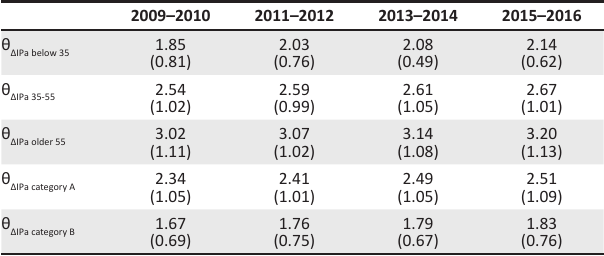
FIGURE 9: Summary of panel data estimations: Change in information